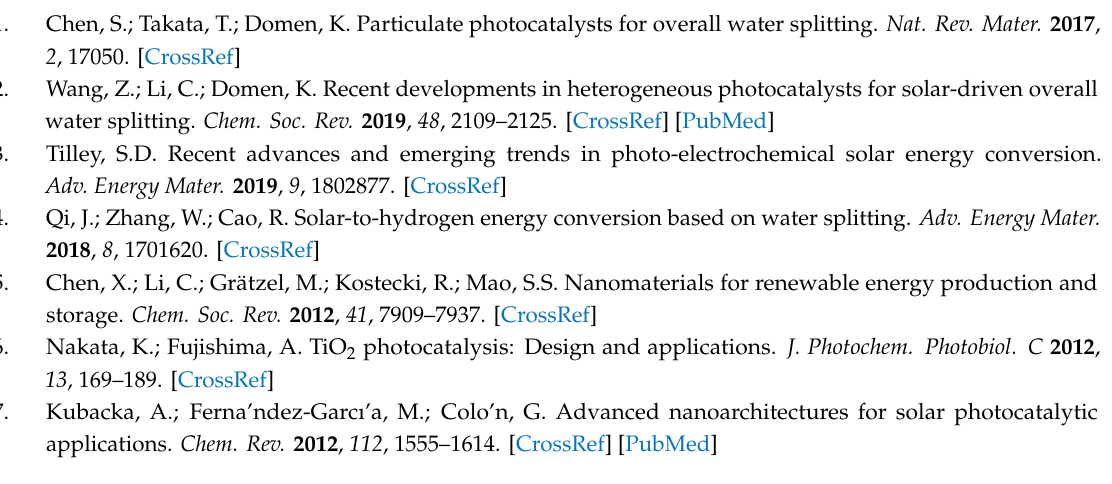
Figure S1: N 2 adsorption-desorption isotherms of Gel-TiO 2 , THPP-TiO 2 , THPP-Pd-TiO 2 and THPP-Zn-TiO 2 at 77 K, Figure S2: The pore size distributions of A) THPP-TiO 2 , B) THPP-Pd-TiO 2 and C) THPP-Zn-TiO 2 , Table S1: BET surface areas, pore volumes and pore widths of Gel-TiO 2 , THPP-TiO 2 , THPP-Pd-TiO 2 and THPP-Zn-TiO 2 derived from 77 K N 2 sorption isotherms, Figure S3: Tauc plots of THPP-TiO 2 , THPP-Pd-TiO 2 , THPP-Zn-TiO 2 and Gel-TiO 2 , Figure S4: Cyclic voltammogram of THPP, THPP-Pd and THPP-Zn in 0.1 M TBAPF 6 THF solution with a scan rate of 40 mV s -1 , Figure S5. Absorption and emission spectra of A) THPP, B) THPP-Pd, and C) THPP-Zn measured in THF solution, Table S2: The energy levels and electrochemical data of THPP, THPP-Pd and THPP-Zn, Table S3: H 2 production data and calculated TON values of hybrid catalysts of THPP, THPP-Pd and THPP-Zn with or without Pt NPs under visible light in 5 h, Table S4: AQY results for H 2 production of Pt / THPP-TiO 2 , Pt / THPP-Pd-TiO 2 and Pt / THPP-Zn-TiO 2 catalysts (6 mg for each sample) after 0.5 h irradiation under 425 nm LED light source, Figure S6: H 2 production curves of Pt / THPP-TiO 2 , Pt / THPP-Pd-TiO 2 , and Pt / THPP-Zn-TiO 2 in an aqueous solution of 10% TEOA under complete UV-vis irradiation, Table S5: H 2 production data and calculated TON values of Pt / THPP-Pd-TiO 2 and Pt / THPP-Pd / TiO 2 in cyclic photocatalytic